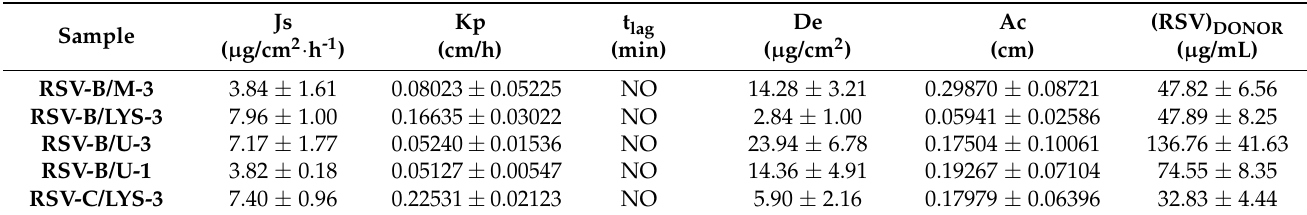
Table 8. Extrapolated RSV biopharmaceutical parameters (Js, Kp, tlag, De and Ac ± SE) and RSV concentration in the donor chamber after CPE-loaded mini-tablets ex vivo permeation tests.